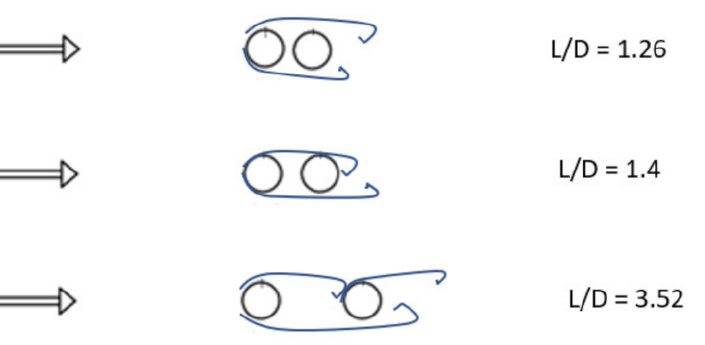
Figure 5. Schematic flow patterns over tandem arrangements with L/D 1.26; L/D 1.4; and L/D